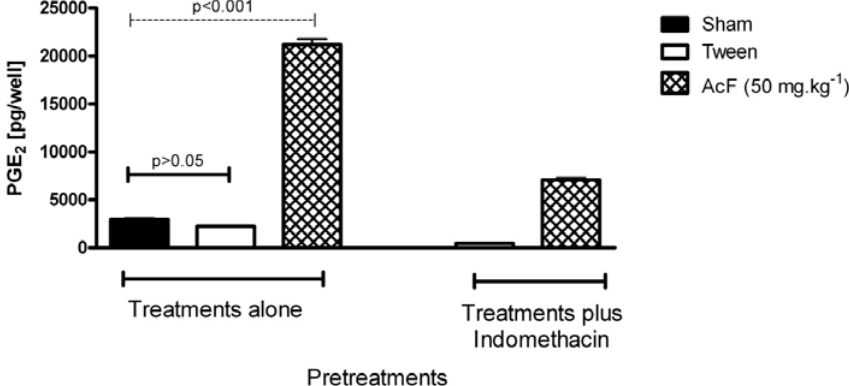
Figure 4. Effects of orally administered ethyl acetate extract (AcF; 50 mg·kg − 1 ) obtained from the leaves of A . Humile St. Hil. and indomethacin on gastric prostaglandin E production in rats.